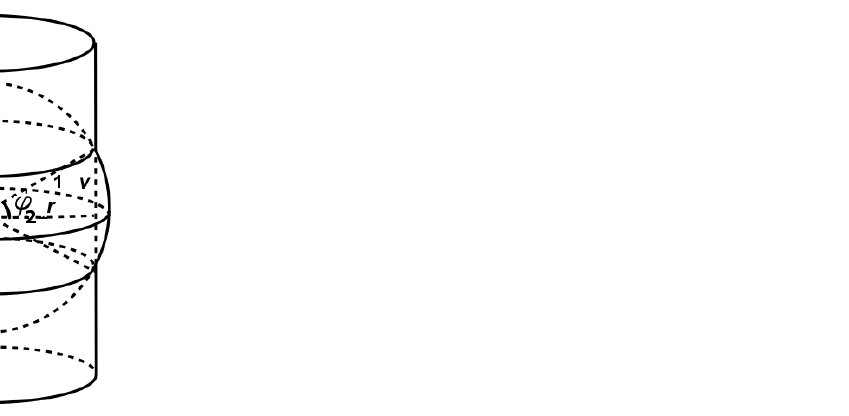
Figure 1. Map in a normal aspect cylindrical projection bent into a cylinder surface that intersects a sphere of radius 1, r is the cylinder radius, v is the height of secant parallel above the plane of the equator.